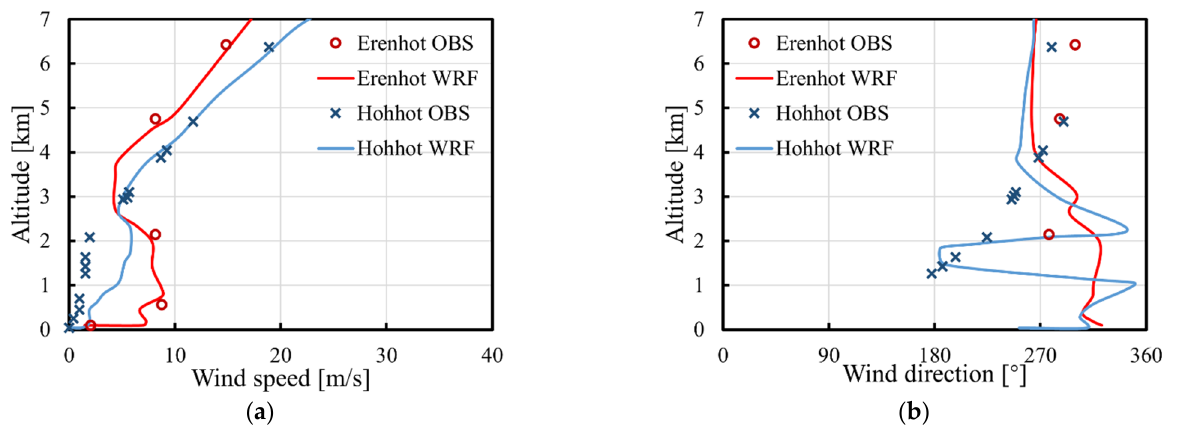
Figure 9. Profiles of ( a ) wind speed and ( b ) wind direction above the main landing area from WRF and upper-atmosphere sounding data at 00:00 LST on 28 September 2008.